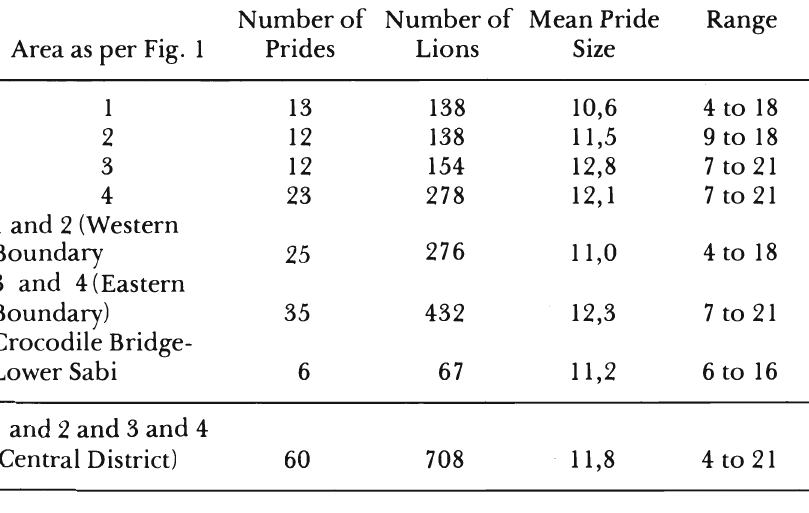
Mean pride sizes for lions from the Central District and the Crocodile Bridge-